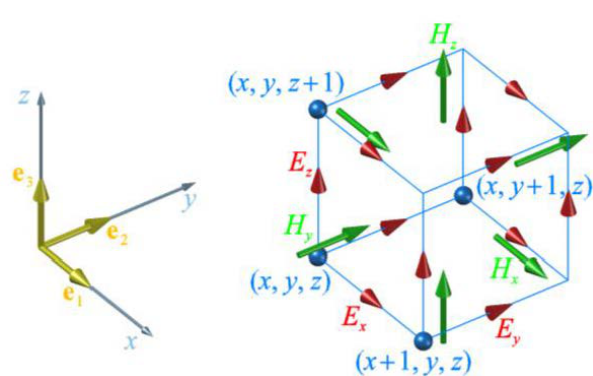
Figure 42: Illustration of a standard Cartesian Yee cell used for FDTD, about which electric and magnetic field vector components are